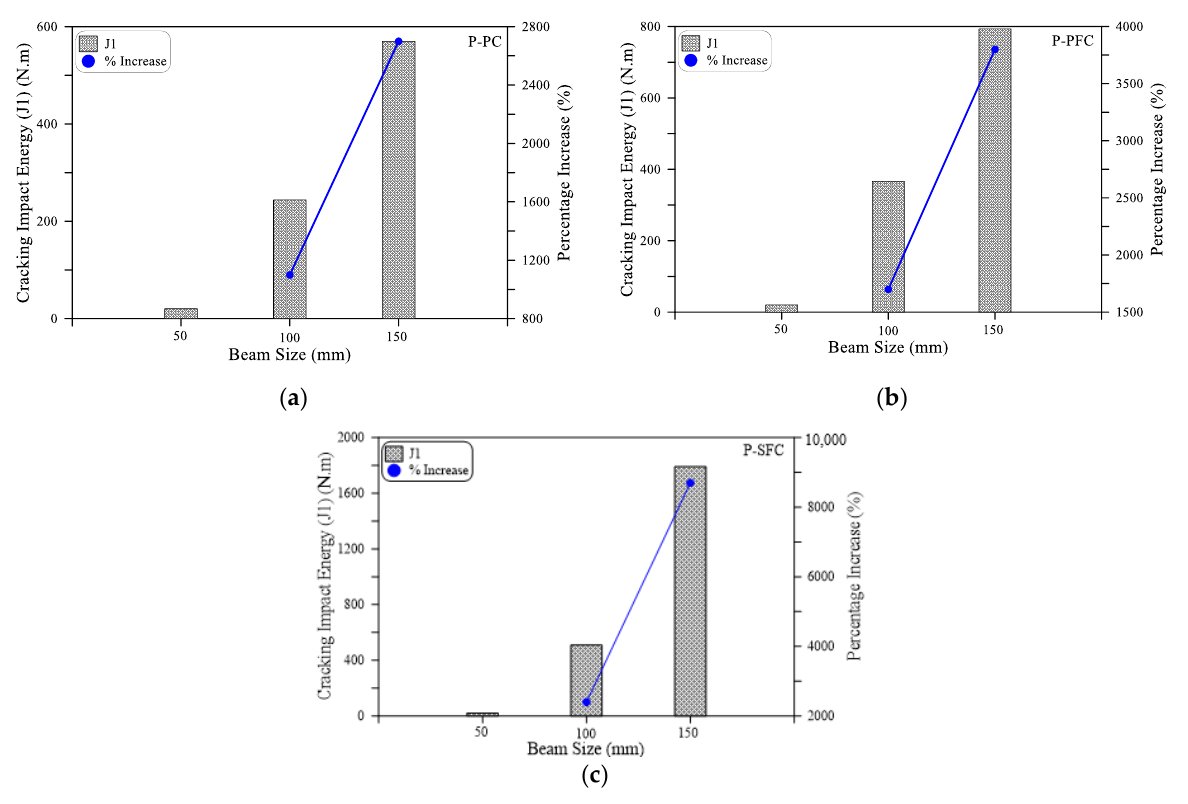
Figure 9. Failed steel fiber-reinforced specimens.